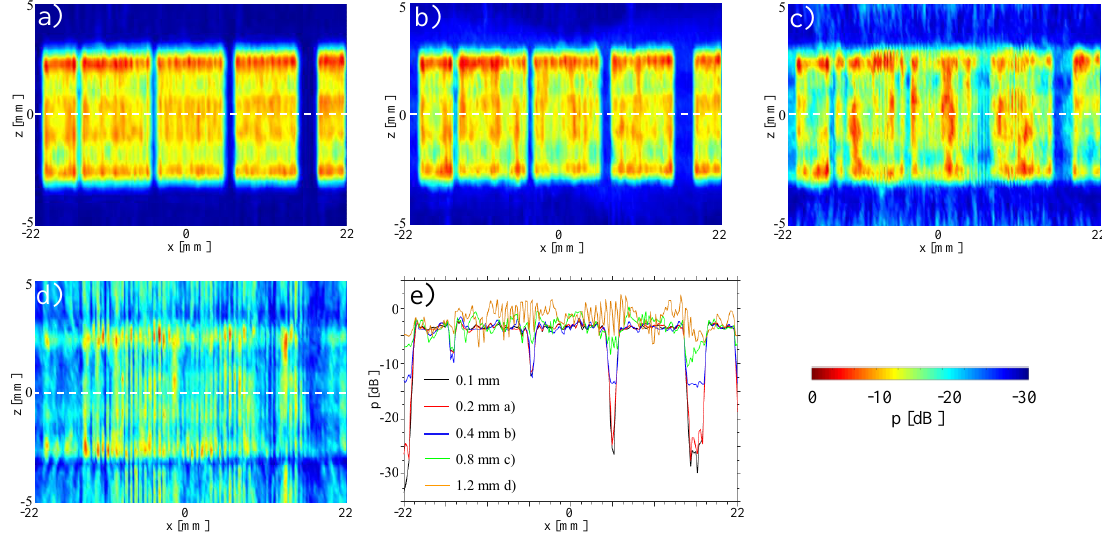
Figure 5. Analysis of the influence of different resolutions of the input area on the re-radiation result: ( a ) 0.2 mm; ( b ) 0.4 mm; ( c ) 0.8 mm; ( d ) 1.2 mm; ( e )